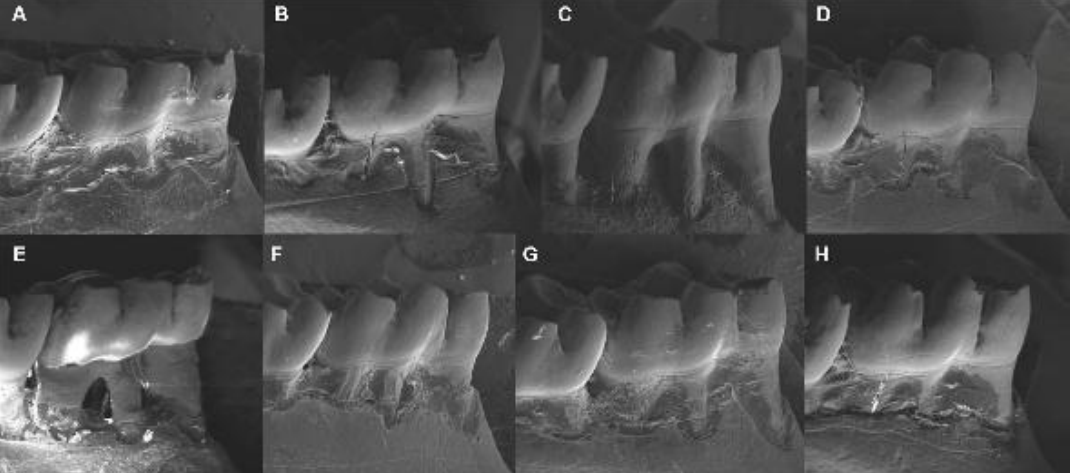
Figure 3. Scanning electron microscopy showing the alveolar bone loss of animals with diabetes and/or periodontal disease treated or not treated with β-glucan at a dose of 30 mg/kg/day for 28 days: